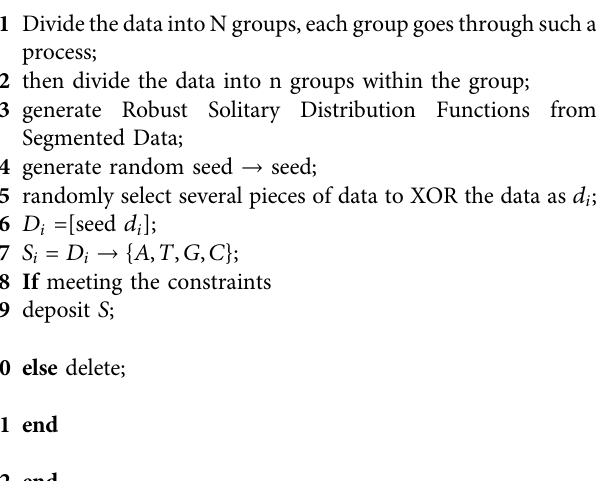
Algorithm 1. Encoding for DNA storage using data hiding addressing